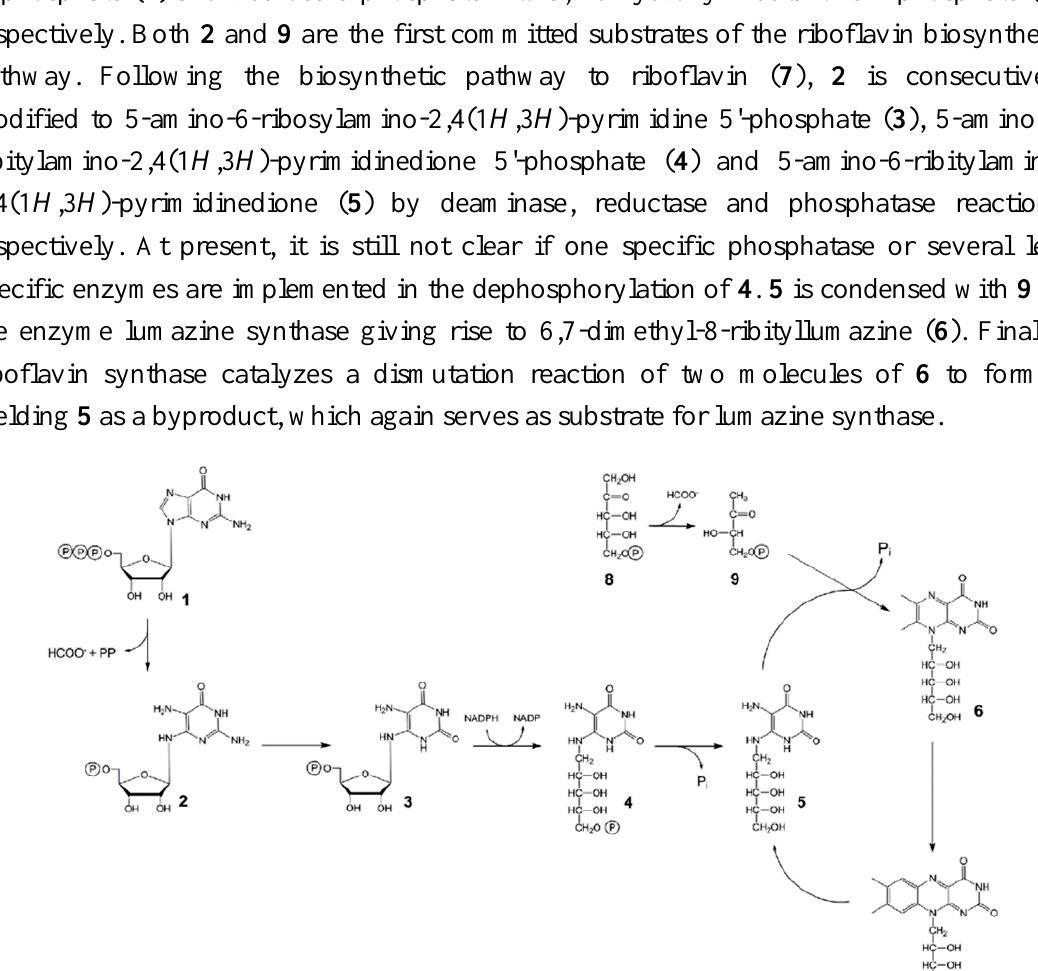
Figure 1. Biosynthesis of riboflavin. Riboflavin biosynthesis is initiated by the enzymes GTP cyclohydrolase II (GCHII) and 3,4-dihydroxy-2-butanone-4-phosphate synthase (DHBPS) converting GTP ( 1 ) into 2,5-diamino-6-ribosylamino-4(3 H )-pyrimidinone 5'-phosphate ( 2 ) and ribulose-5-phosphate into 3,4-dihydroxy-2-butanone 4-phosphate ( 9 ), respectively. Both 2 and 9 are the first committed substrates of the riboflavin biosynthetic pathway. Following the biosynthetic pathway to riboflavin ( 7 ), 2 is consecutively modified to 5-amino-6-ribosylamino-2,4(1 H ,3 H )-pyrimidine 5'-phosphate ( 3 ), 5-amino-6- ribitylamino-2,4(1 H ,3 H )-pyrimidinedione 5'-phosphate ( 4 ) and 5-amino-6-ribitylamino- 2,4(1 H ,3 H )-pyrimidinedione ( 5 ) by deaminase, reductase and phosphatase